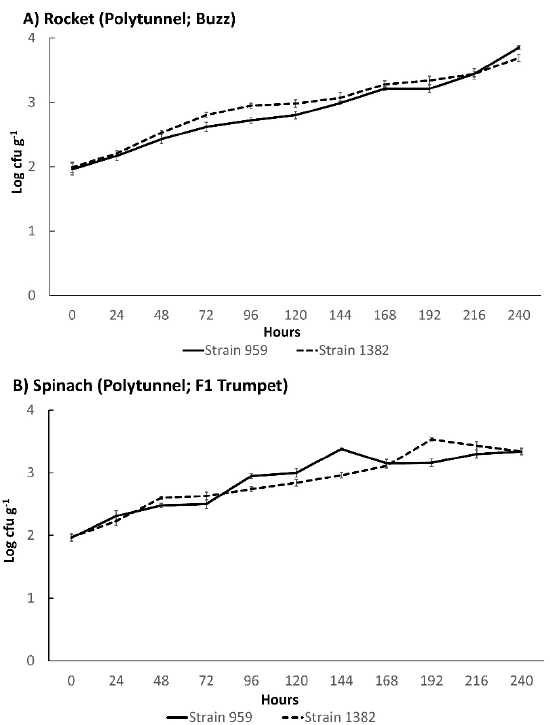
Figure 3. Growth curves of single L. monocytogenes strains 959 (Solid line) and 1382 (Dashed line) on experimental farm produce: ( A ) polytunnel rocket (Buzz) and ( B ) polytunnel spinach (F1 Trumpet). Incubated at 8 °C for 10 days. (±) error bars indicate standard deviation.